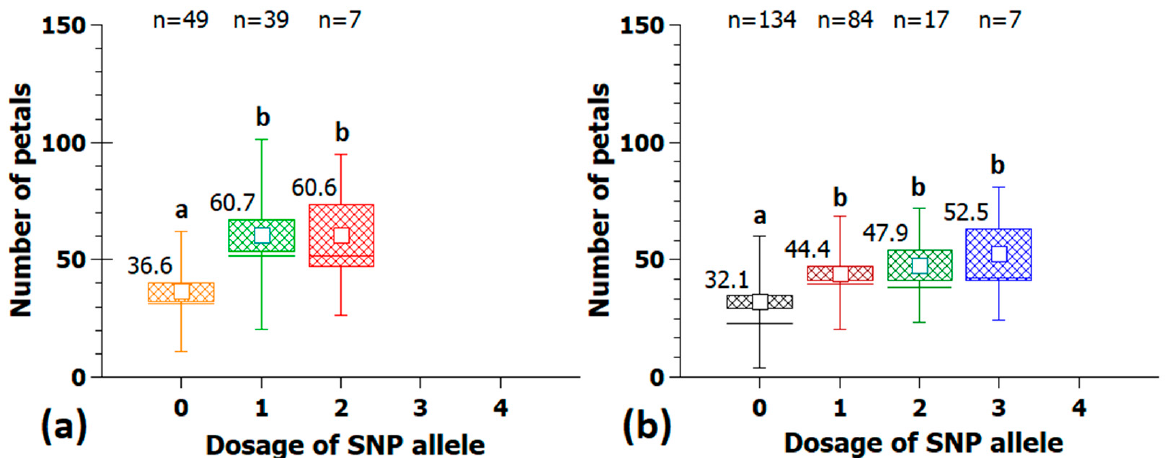
Figure 4. ( a ) Effect of KASP-marker Rh_PN_SNP6K (chr1; 53.2 Mbp) on petal number in the association panel and ( b ) validation of the same marker with 242 independent cultivars. Shown are the number of individuals in each group and the average number of petals/flower. Letters above the whiskers mark groups that are significantly different at p ≤ 0.05 (Kruskal-Wallis analysis of variance on ranks with all pairwise multiple comparisons (Dunn’s method).